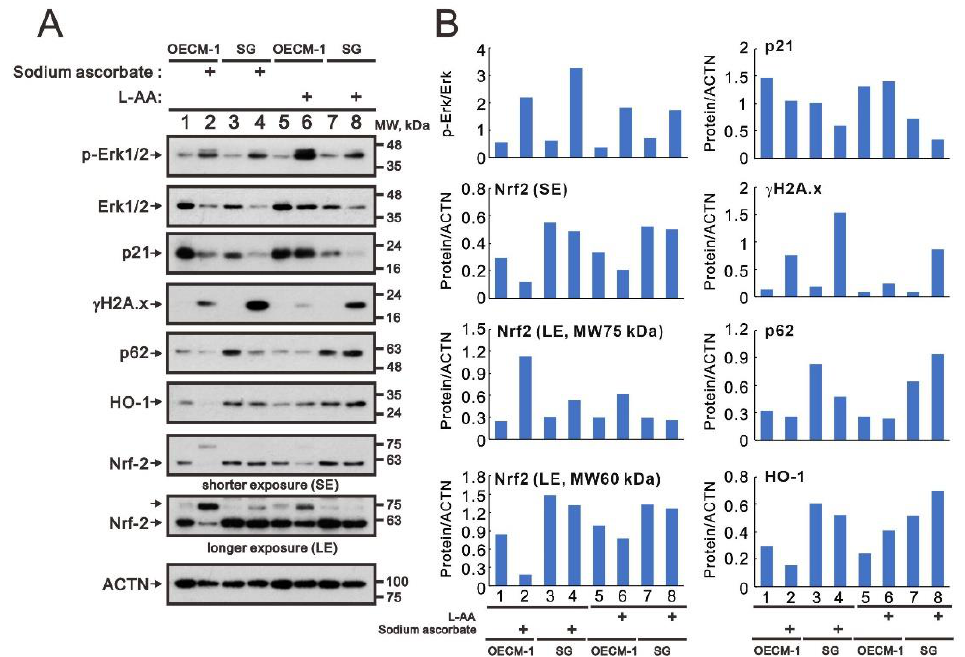
Figure 4. Effects of sodium ascorbate and L-ascorbic acid on the oxidative-stress proteins in OECM-1 and SG cells. OECM-1 (2.5 × 10 5 ) and SG cells (2.5 × 10 5 ) were cultured in 6-well plates and treated with 10 mM sodium ascorbate for 3.5 h or L-ascorbic acid for 5.5 h. ( A ) The cell lysates (30 µg total proteins) were subjected to Western Blot analysis using antibodies against the indicated proteins. ACTN was a loading-protein control. The protein bands ( B ) were quantified through pixel density scanning and evaluated using Image J, version 1.44a (http://imagej.nih.gov/ij/) (accessed on 1 February 2023). The ratios of p-Erk/Erk and protein/ACTN were plotted in the OECM-1 and SG cells.